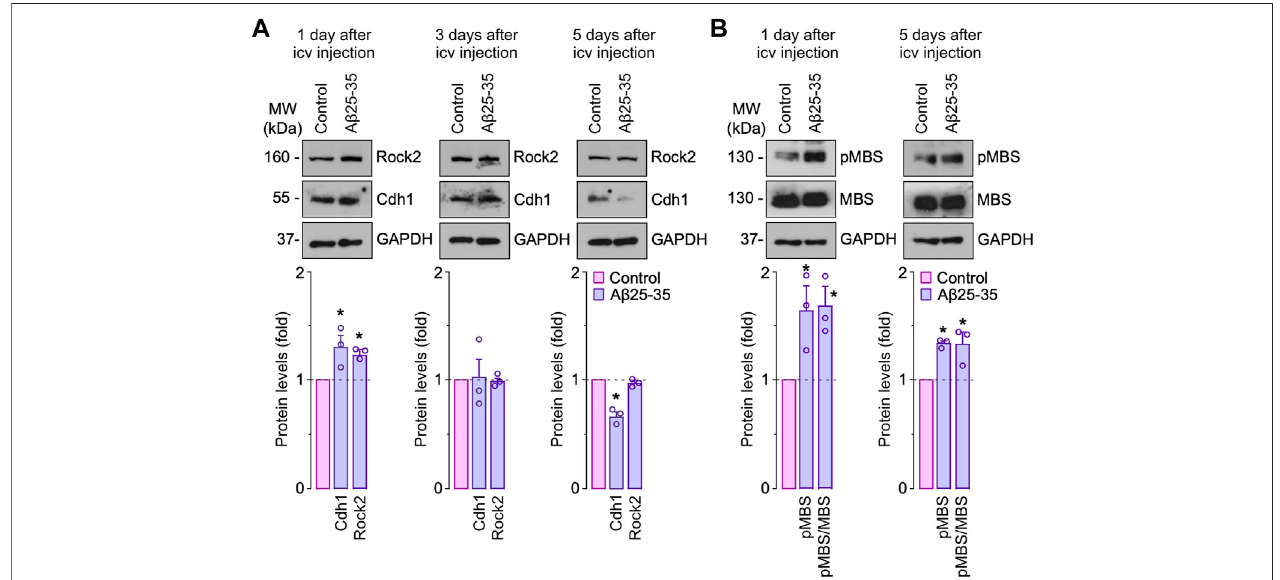
FIGURE5| Amyloid- β (A β )promotes Rock2stabilization andactivationinthehippocampus invivo . Intracerebroventricular stereotacticinjections ofsaline(control) or oligomerized A β 25-35 (9 nmol) were performed into 12-week-old male mice. Hippocampus extracts were obtained at different days after injections. (A) Rock2 and Cdh1 western blot analysis in hippocampus extracts (GAPDH, loading control). Rock2 and Cdh1 western blot bands were quanti fi ed by densitometry and results were expressed as the fold change relative to control. (B) MBS and pMBS western blot analysis in hippocampus extracts (GAPDH, loading control). MBS and pMBS western blot bands were quanti fi ed by densitometry and results were expressed as the fold change relative to control. Data are mean ± SEM from 3 mice. * p < 0.05 versus control.